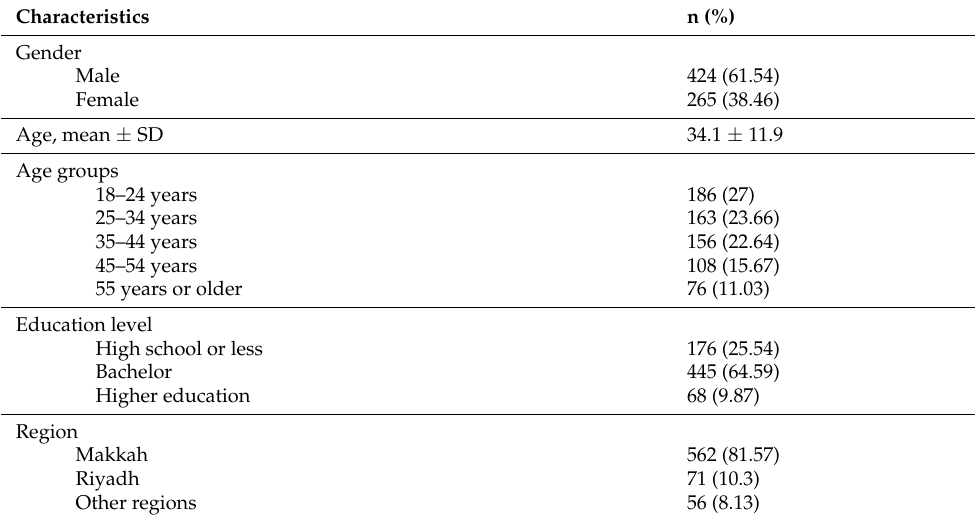
Table 1. Characteristics of the study participants (N =